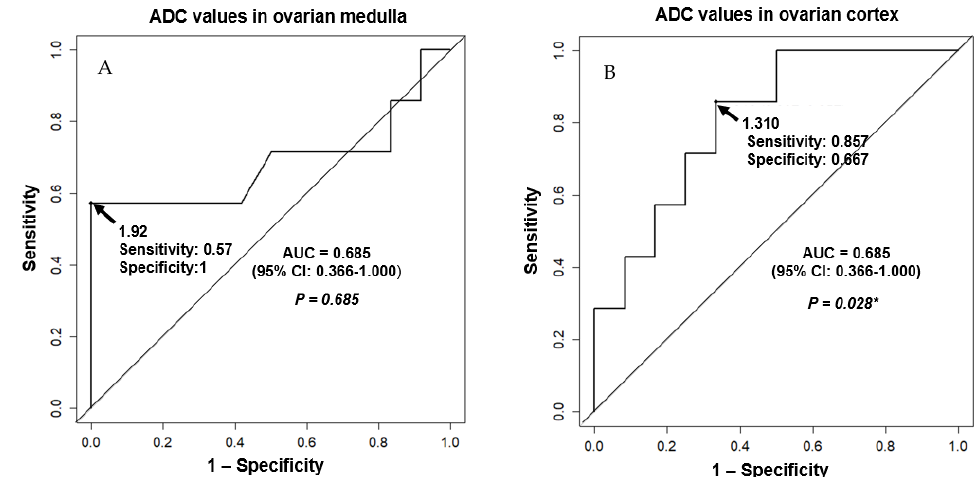
Figure 5. Receiver operating characteristic curves of ACD for predicting the severity of hemorrhagic infarction in the torsed maternal ovary during pregnancy. Receiver operating characteristic curves for necrosis based on ADC values between ovarian medulla and cortex for predicting ovarian necrosis of maternal adnexal torsion during pregnancy are shown. ( A ) Optimal cut-off ADC value for predictable total necrosis in torsed ovarian medulla was ≤ 1.92 × 10 − 3 mm 2 / s (area under the curve (AUC) = 0.685; 95% CI 0.366–1.0; P = 0.685). Sensitivity of 57.1% (4 / 7), The specificity of 100.0% (12 / 12), PPV of 100.0% (4 / 4), NPV of 80.0% (12 / 15), false positive of 0.0% (0 / 12), false negative of 42.9% (3 / 7) was obtained, respectively. ( B ) Optimal cut-off ADC value for predictable total necrosis in torsed ovarian cortex was ≤ 1.31 × 10 −3 mm 2 /s (area under the curve (AUC) = 0.81; 95% CI 0.611–1.0; P = 0.028). The sensitivity of 85.7% (6 / 7), specificity of 66.7% (8 / 12), PPV of 60.0% (6 / 10), NPV of 88.9% (8 / 90), false positive of 33.3% (4 / 12), false negative of 14.3% (1 / 7) were obtained, respectively. * represents significant results. ADC, apparent diffusion coefficient; AUC, area under the curve; ROC, Receiver operating characteristic curves; PPV, positive predictive value; NPV, negative predictive value; 95% CI, 95% confidence interval.